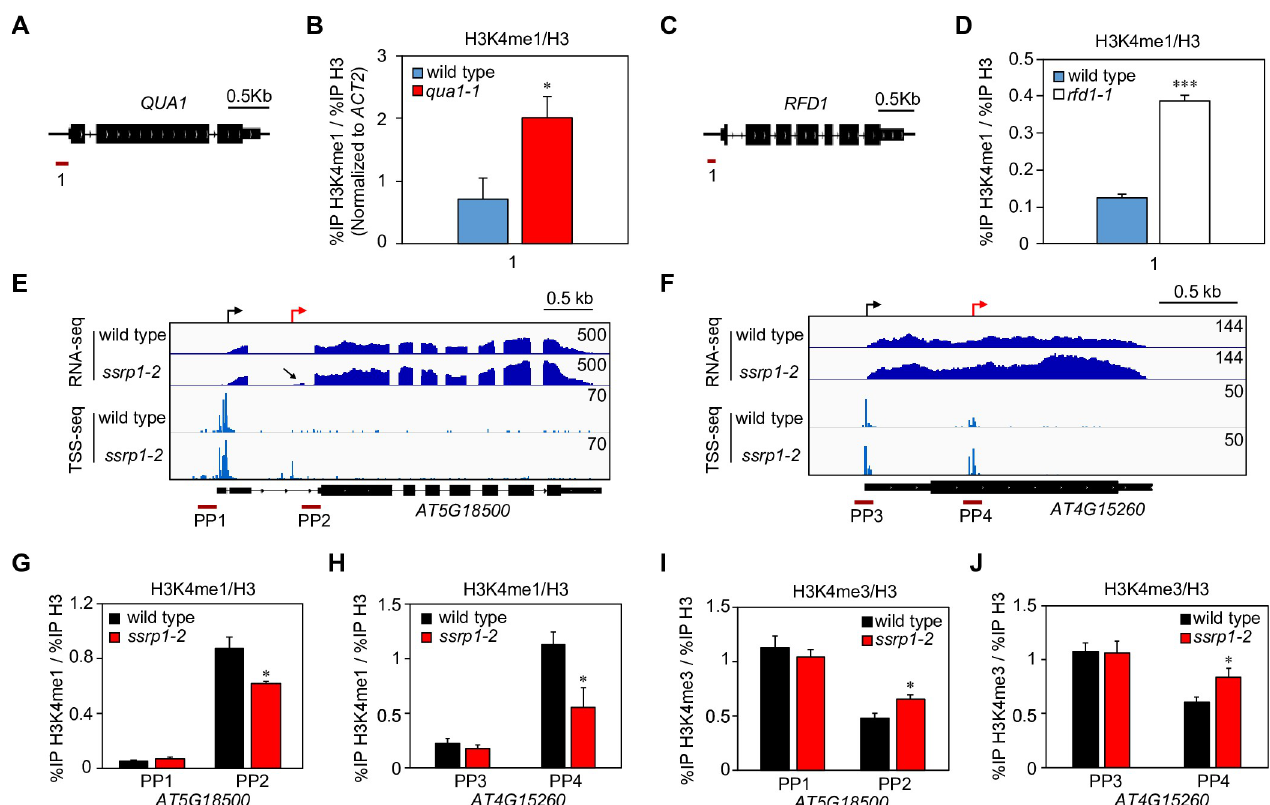
Fig 7. Activation of intragenic TSSs in fact mutant accompanies a shift from H3K4me1 to H3K4me3. (A) Schematic representation of the QUA1 gene, including primer pair positions for qChIP. (B) qChIP in wild type (WS) and qua1-1 using the QUA1 promoter-proximal primer pair 1 (See panel A). Note: For comparisons between wild type WS and qua1-1 , qChIP values were normalized to reference gene ACT2 (See methods for more details). (C) Schematic representation of the RFD1 gene, including primer pair positions for qChIP. (D) qChIP for H3K4me1 in wild type (Col-0) and rfd1-1 using RFD1 promoter- proximal primer pair 1 (See panel C). Screenshot of RNA-seq and TSS-seq data from wild type and ssrp1-2 depicting novel intragenic transcripts emerging from fact -specific TSSs (red arrows) at the (E) AT5G18500 and (F) AT4G15260 genes. qChIP for H3K4me1 levels at (G) the canonical AT5G18500 promoter (PP1) and fact -specific TSS (PP2) as well as at (H) the canonical AT4G15260 promoter (PP3) and fact -specific TSS (PP4) in wild type and ssrp1-2 . qChIP for H3K4me3 levels at (I) the canonical AT5G18500 promoter (PP1) and fact -specific TSS (PP2) as well as at (J) the canonical AT4G15260 promoter (PP3) and fact -specific TSS (PP4) in wild type and ssrp1-2 . Error bars represent standard error of means resulting from at least three independent replicates. For statistical tests, a single asterisk denotes p < 0.05 between samples by Student’s